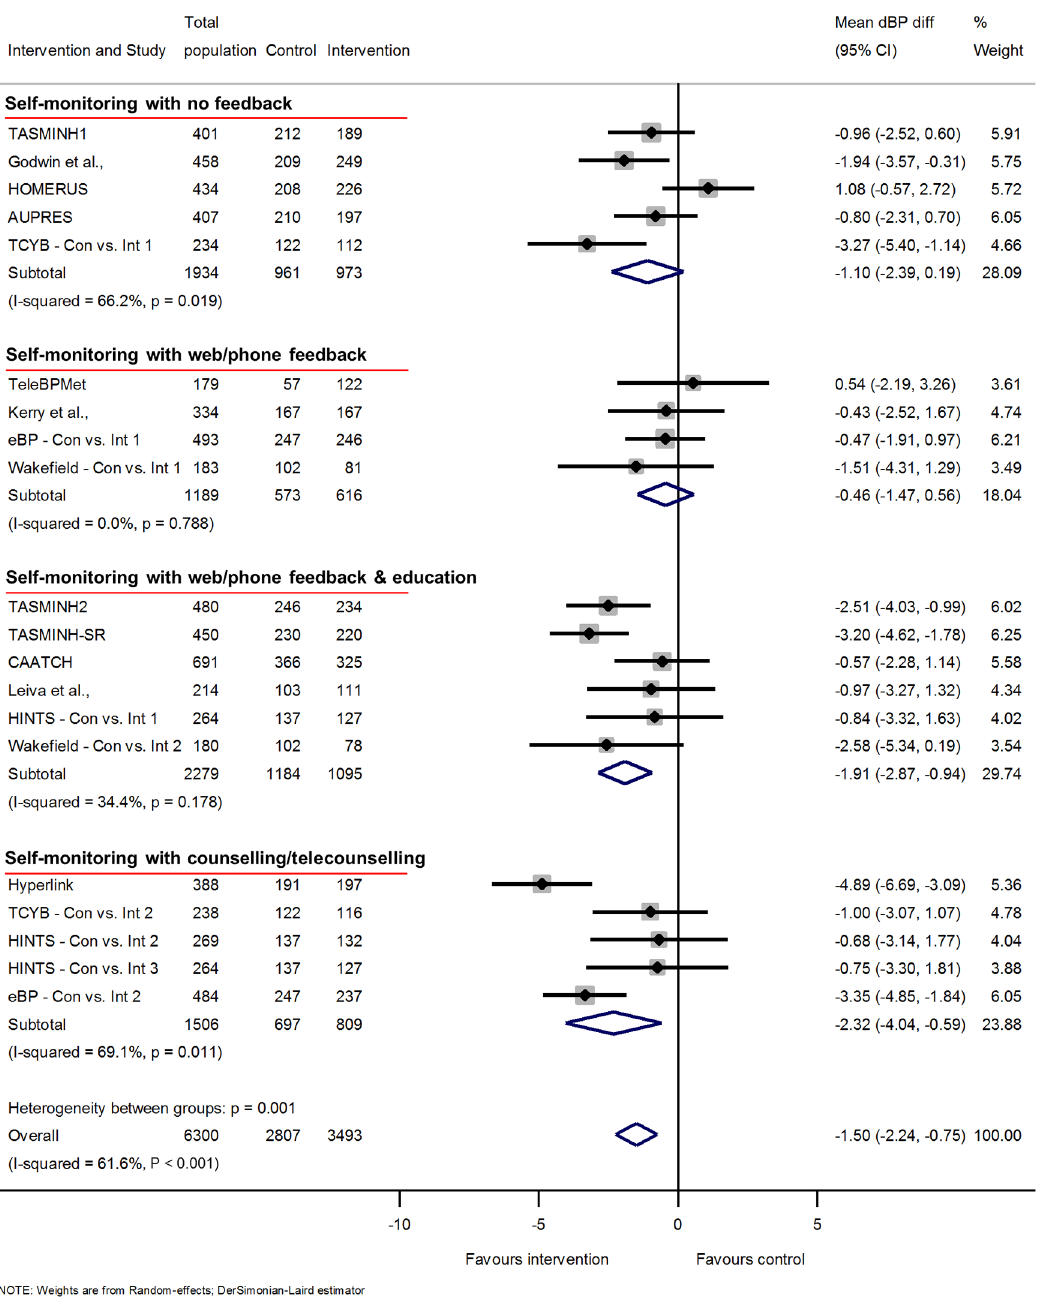
PLOS Medicine| https://doi.org/10.1371/journal.pmed.1002389 September 19,